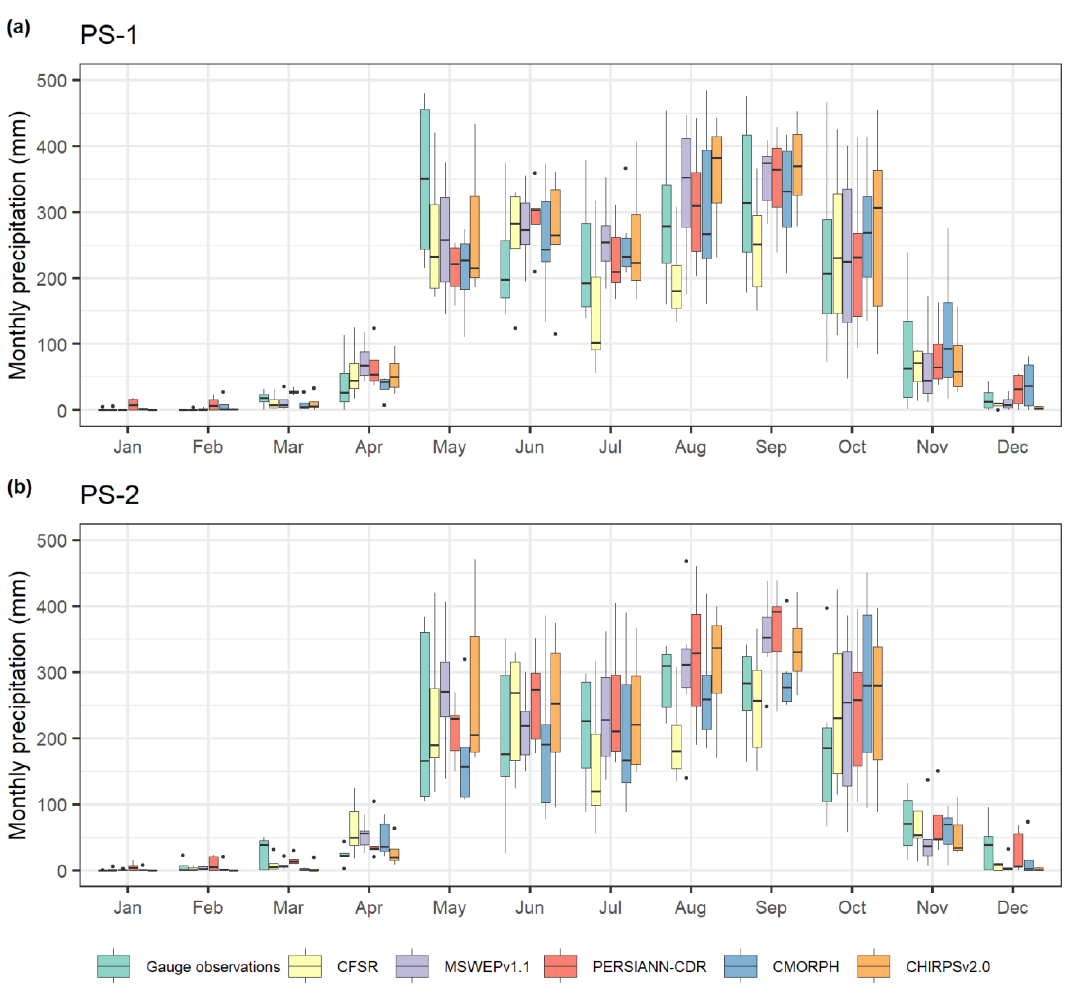
Figure 4. Box plot with the temporal distribution of the monthly precipitation of the gauge observations and of different GP products in ( a ) PS-1 station and ( b ) PS-2 station. Dots denote outliers.